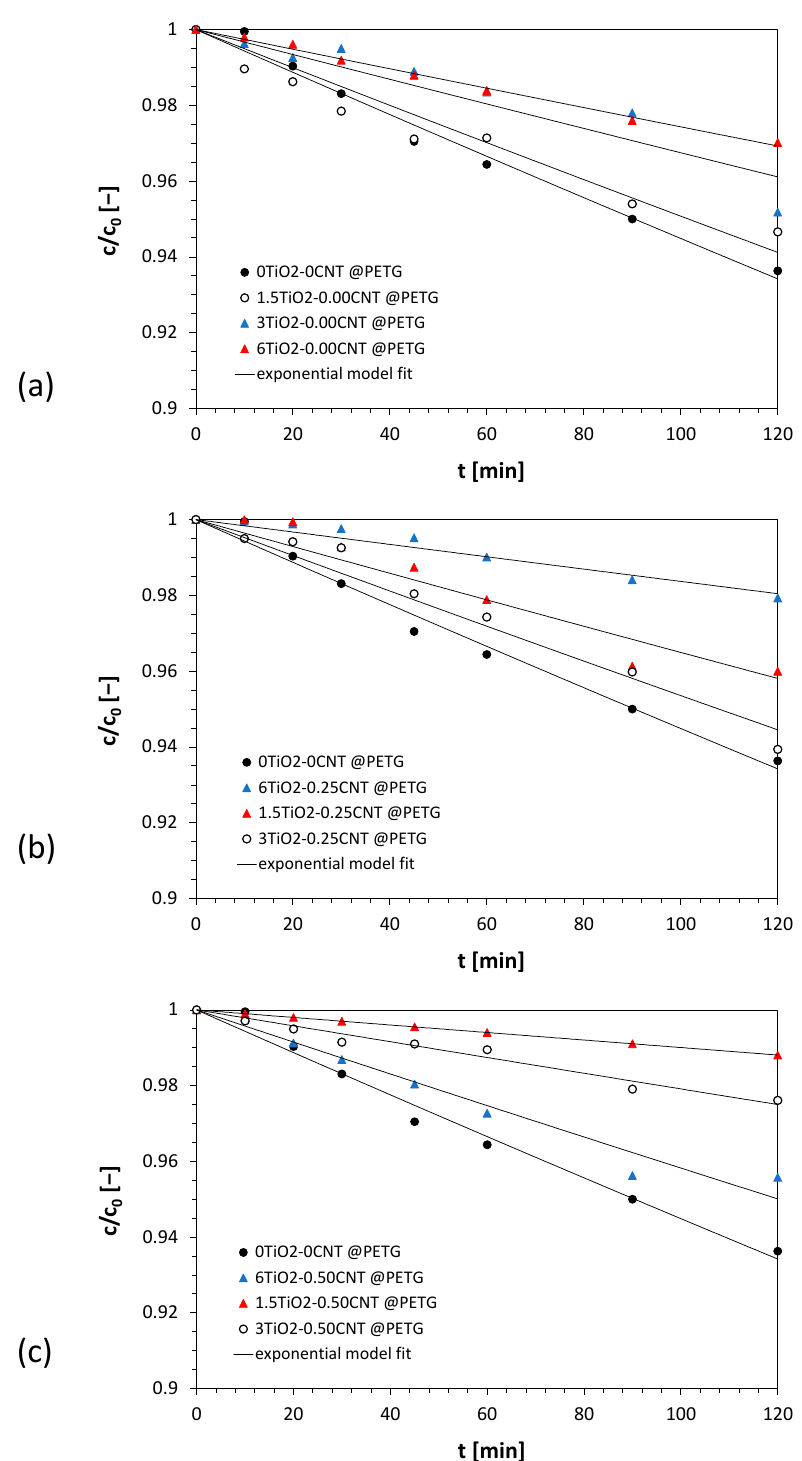
Figure 3. Comparison of observed amoxicillin decomposition trends with static mixers with different concentrations of TiO 2 and CNTs and reference mixer. Kinetics of amoxicillin decomposition using static mixer 0CNT@PETG ( a ), 0.25CNT@PETG ( b ) and 0.50CNT@PETG ( c ). For each static mixer, the decomposition rate constant was determined, as shown in the Figure 4.